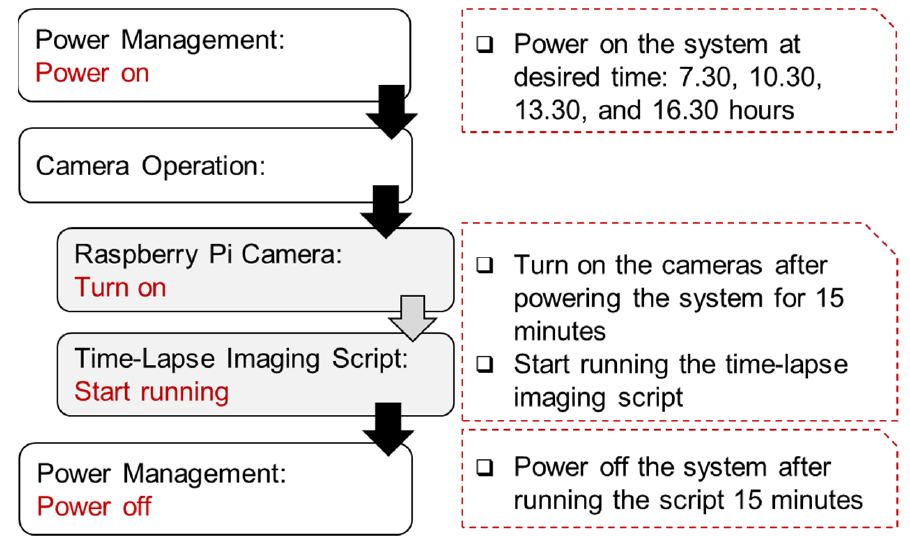
Figure 2. System operation protocol at each time point. The user can define the operational settings, time points, and the number of images.